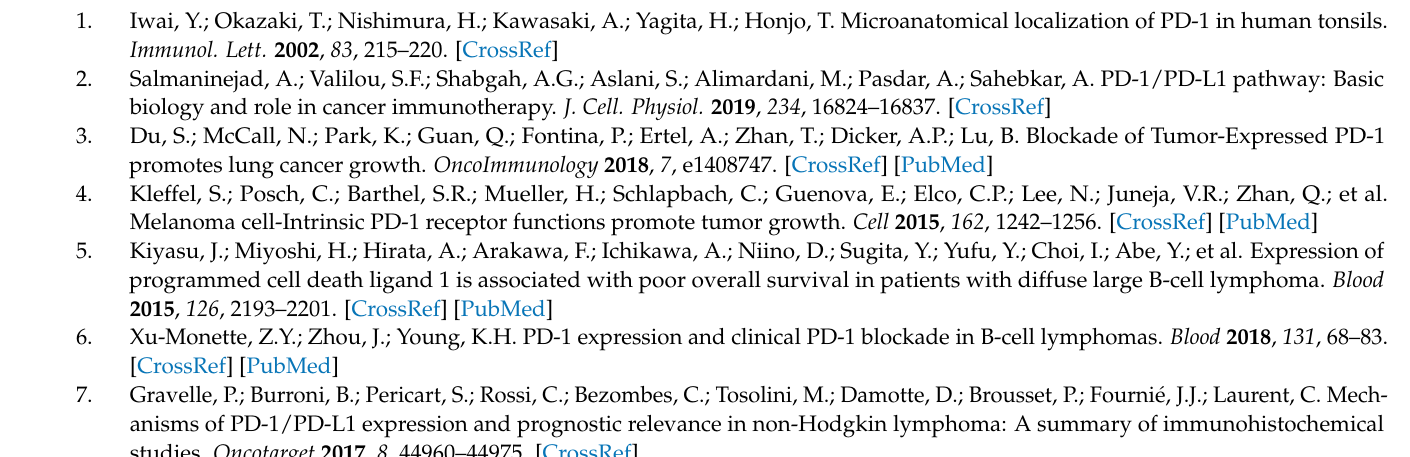
DLBCL, Figure S1: A representative image of MC-IF for PD-1 and CD3 of a patient with de novo DLBCL, Figure S2: Generation of PDCD-1 (PD-1)- knockout VAL cells, Figure S3: A representative image of MC-IF for PD-1, PD-L1, CD3, and PAX5 of a patient with follicular